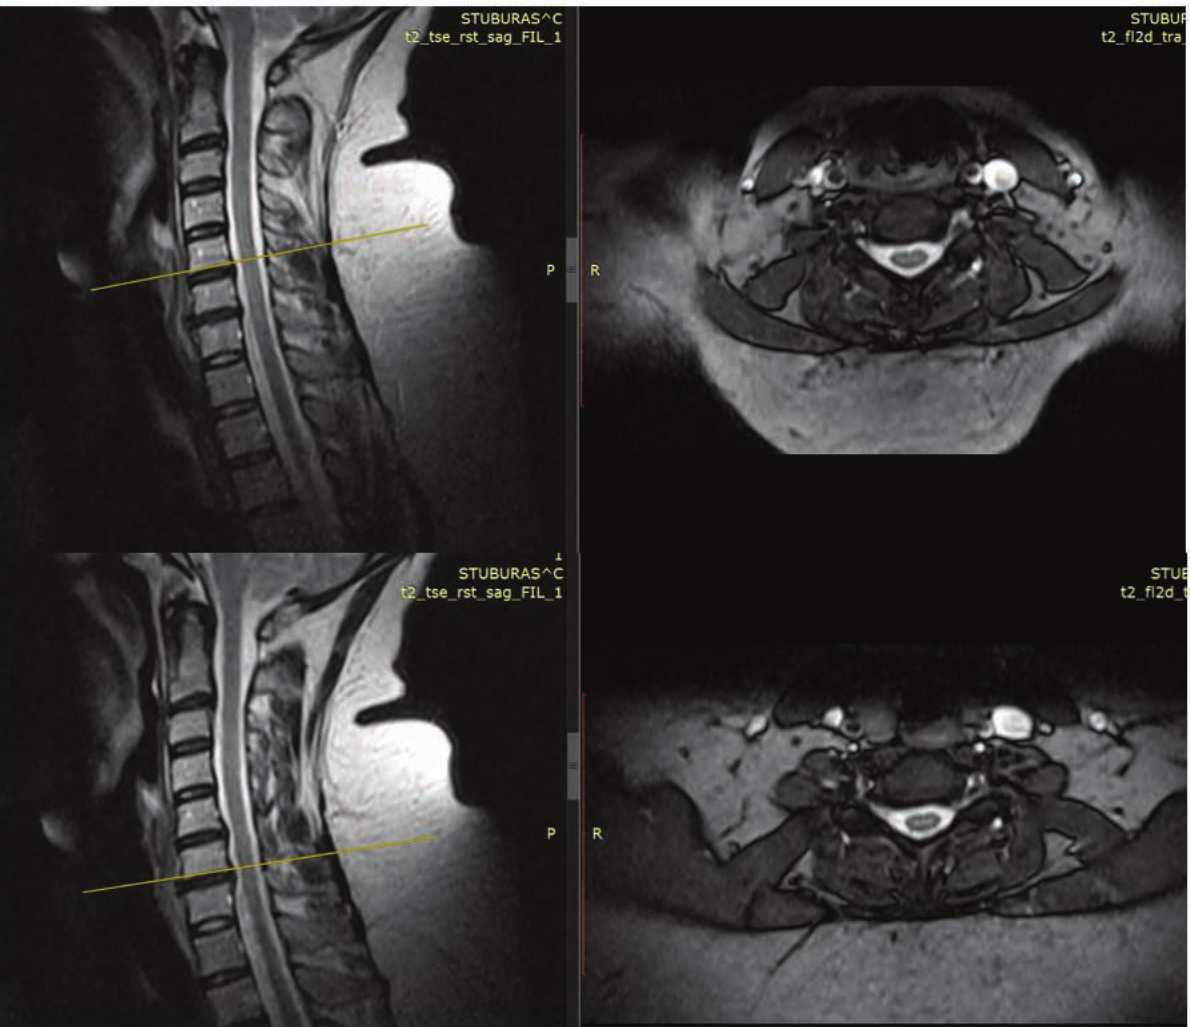
Figure 1: Magnetic resonance imaging of the cervical spine shows intervertebral hernias in C5-C6, C6-C7, and cervical spinal